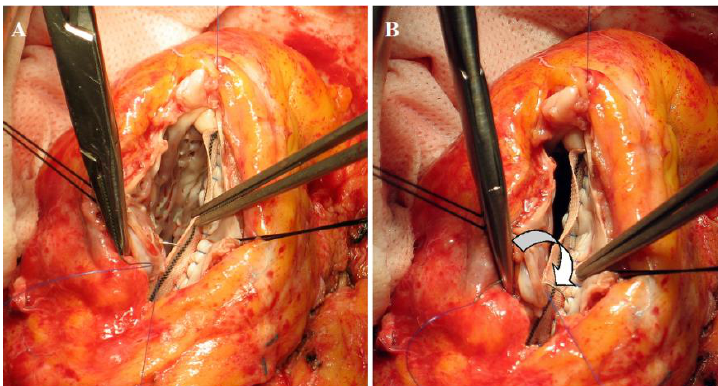
Figure 7. Surgical technique to re-approach fibers’ bundles in a physiologic disposition. Panels ( A ) and ( B ) depict the stretching of the suture that approaches and fits the lateral ventricular wall to the patch. The arrow in panel ( B ) shows how the suture redirects fiber orientation, approaching a farer point of the myocardial wall to a nearer point on the patch. Adapted from the reference [76].